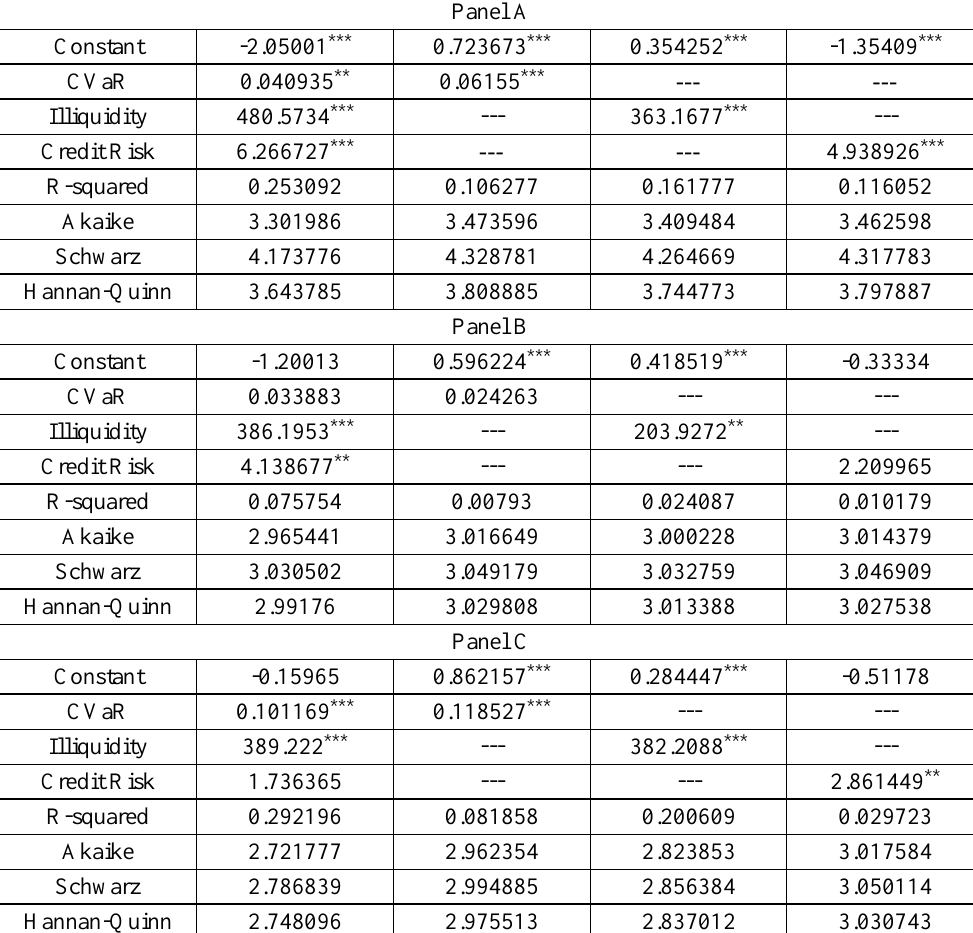
Table 2: Comparison of the effect of market risk, illiquidity risk and credit risk on return